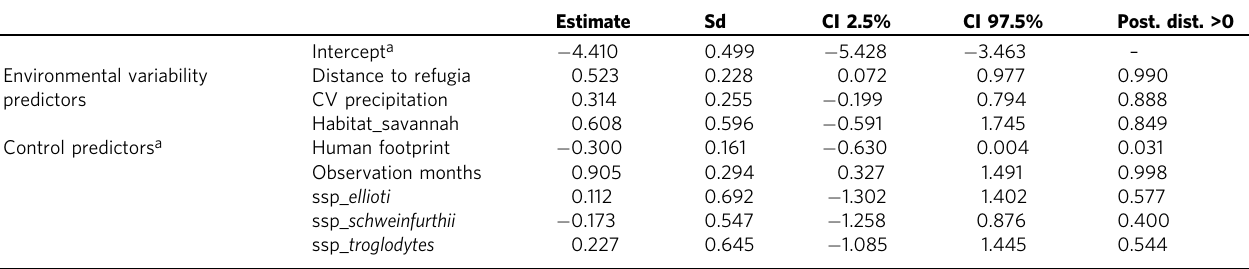
Table 1 Results of three Bayesian Regression Models based on weak priors testing the probability of occurrence of all 31 behaviours in a chimpanzee community ( N = 144) as a function of three predictors of environmental